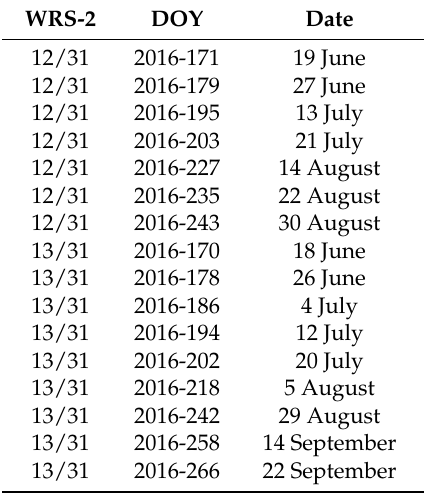
Table 1. Image dates used in 2016 gypsy moth defoliation